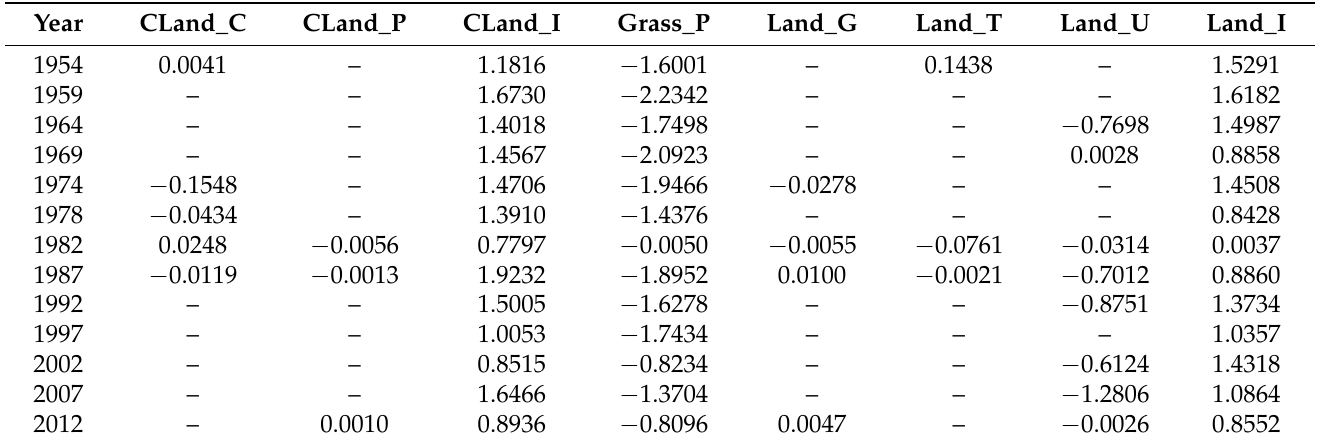
Table A1. Parameter estimates using penalty estimates via SCAD under a spatial logistic